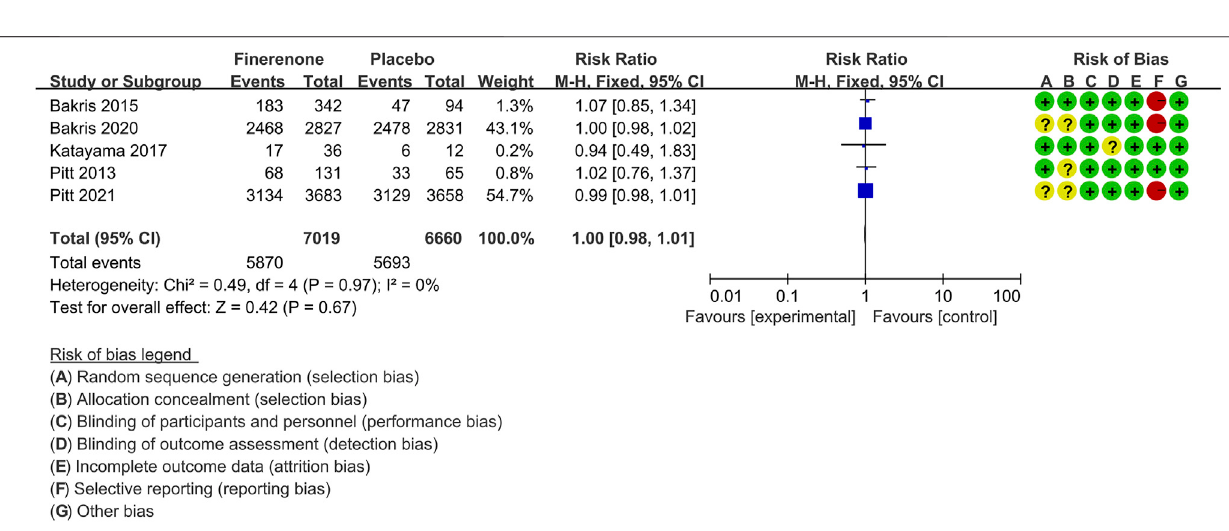
FIGURE 10 | Meta-analysis results of adverse events in fi nerenone compared to placebo patient